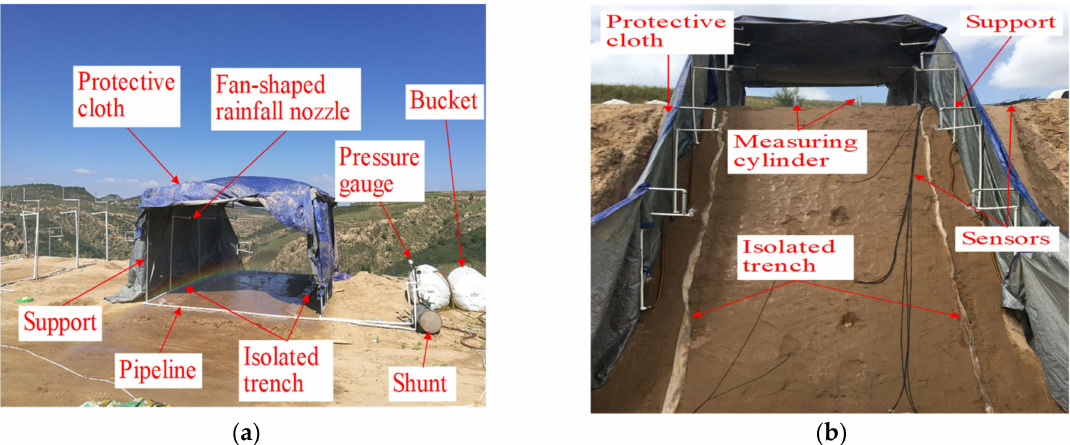
Figure 5. Rainfall on test site: ( a ) rainfall on the slope crest; ( b ) rainfall on the slope